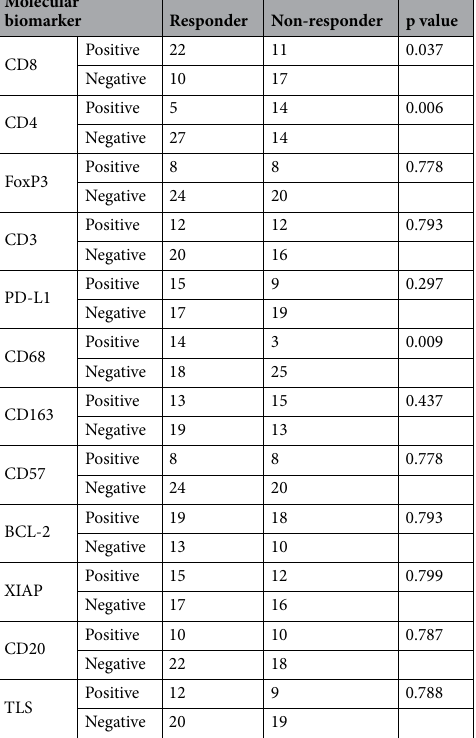
Table 2. Fisher’s exact test results between immunohistochemistry status and response. CD cluster of differentiation, FoxP3 forkhead box P3, PD-L1 programmed death-ligand 1, BCL2 B-cell/CLL lymphoma